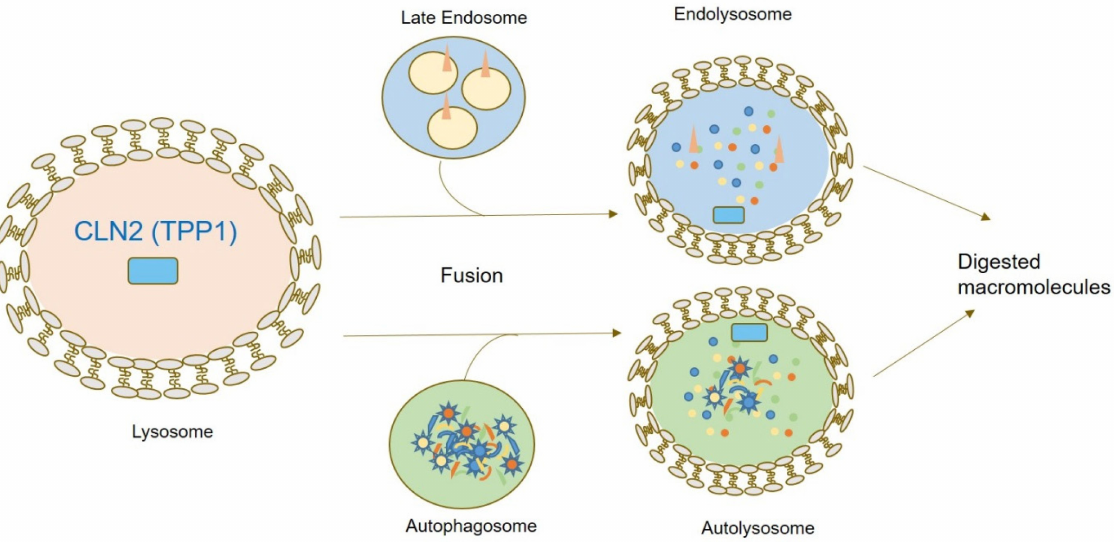
Figure 2. Graphical summary of CLN2/TPP1 localization and function within the cell. TPP1 repre- sents a peptidase contributing to N-terminal protein degradation. Upon fusion of autophagosomes and late endosomal vesicles with lysosomal vesicles, lysosomal enzymes including TPP1 enable digestion of